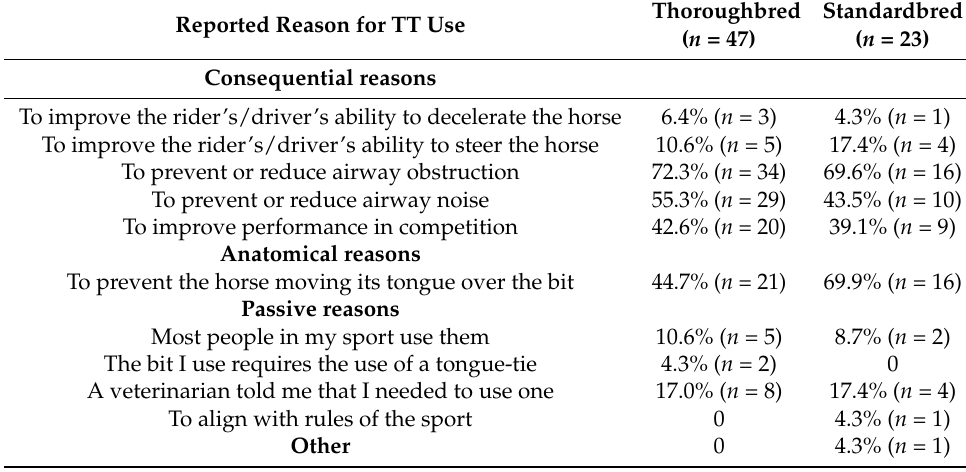
Table 2. The reasons for use of TTs nominated by TB ( n = 47) and SB ( n = 23) racehorse trainers. A median of 3 reasons was nominated by both TBTs and SBTs.